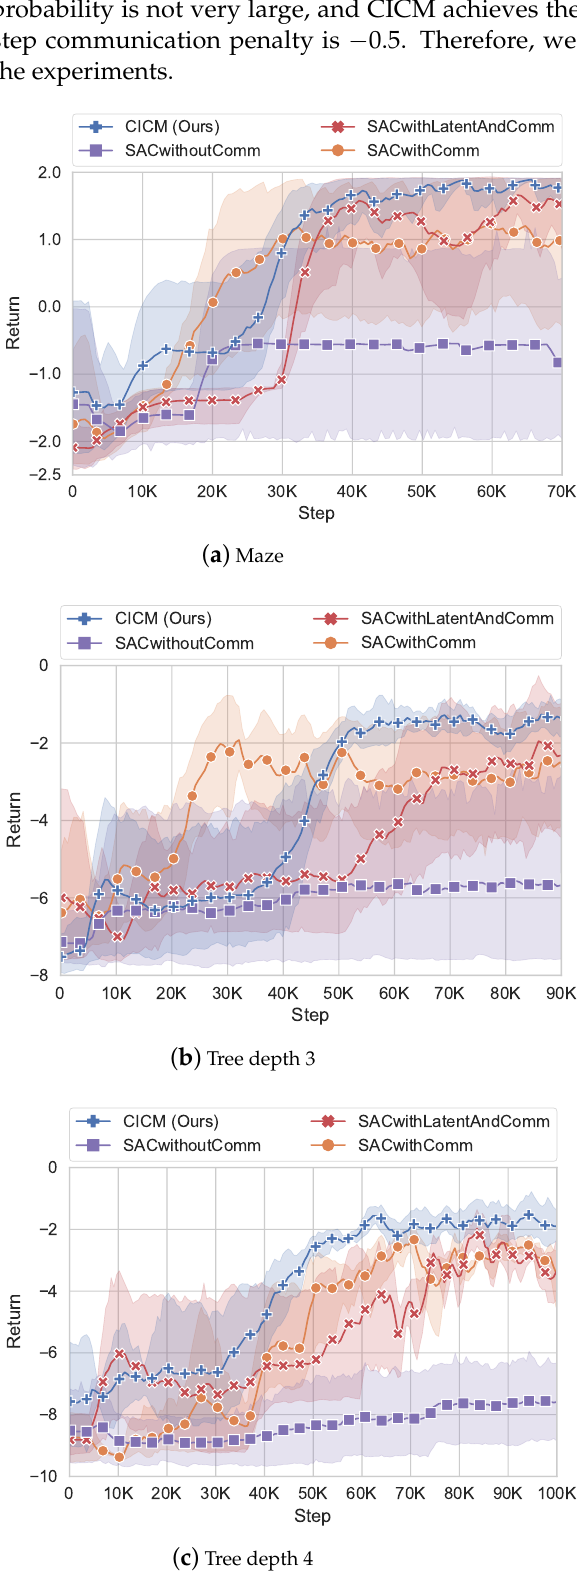
Figure 7. Return in the StarCraft environment. Error bars are one standard deviation over 6 runs. The communication penalty is set to r comm-penalty = −